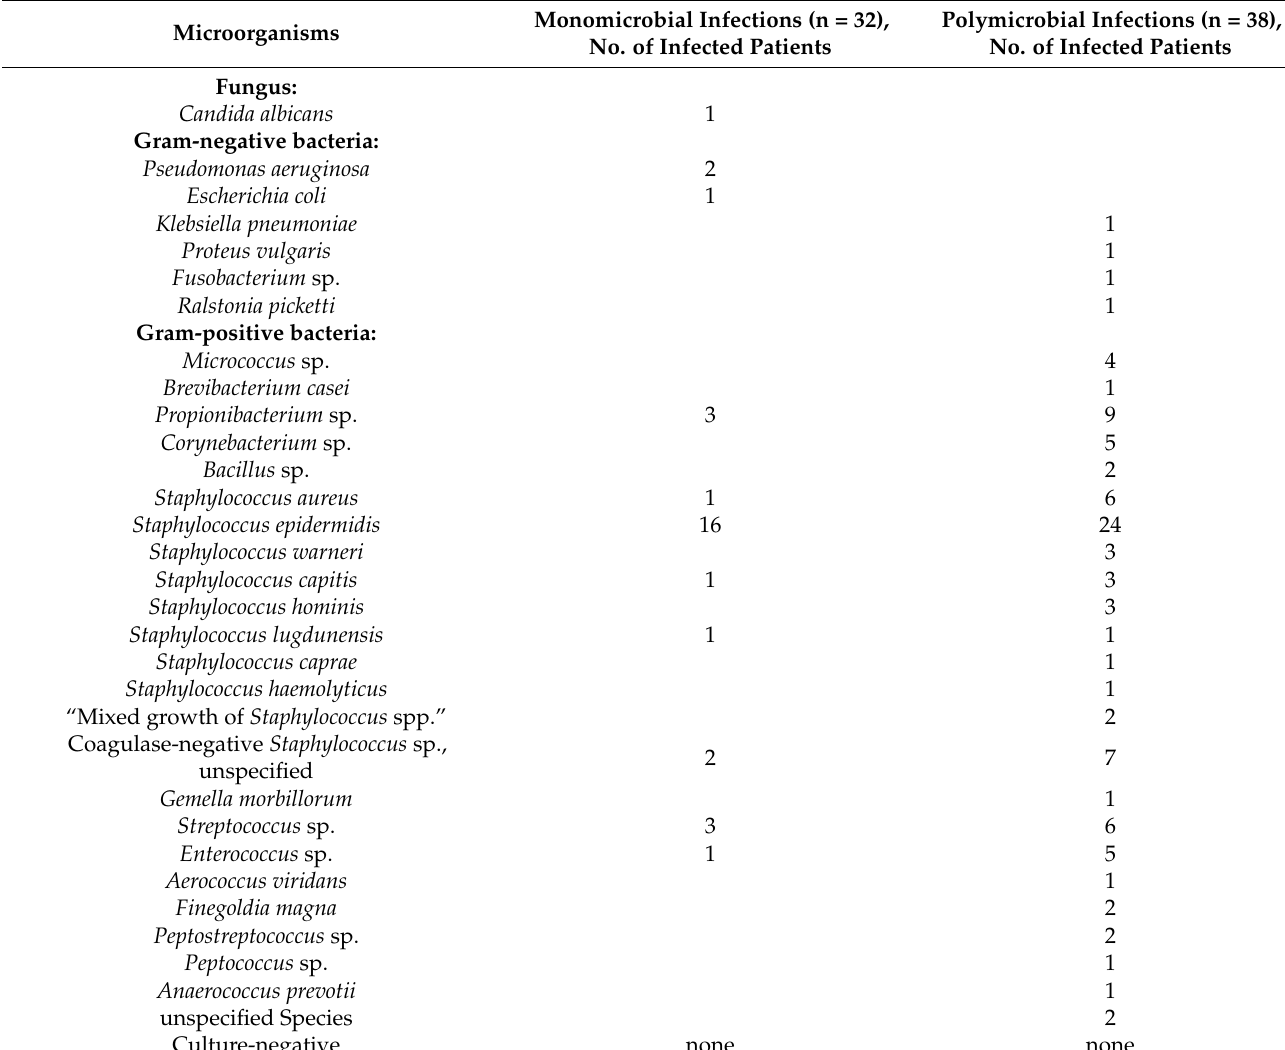
Table 2. Identified microbial pathogens in 70 patients. Monomicrobial Infections (n = 32), Microorganisms No. of Infected Patients